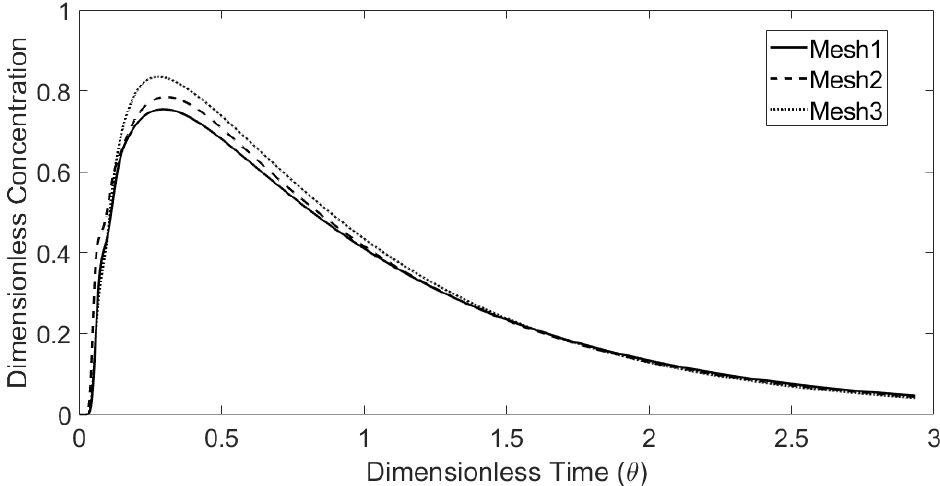
Figure 5. Comparison of calculated E ‐ curves with different CFD mesh number. Table 3. The computational RTD parameters and volume fraction of flow with different mesh size.